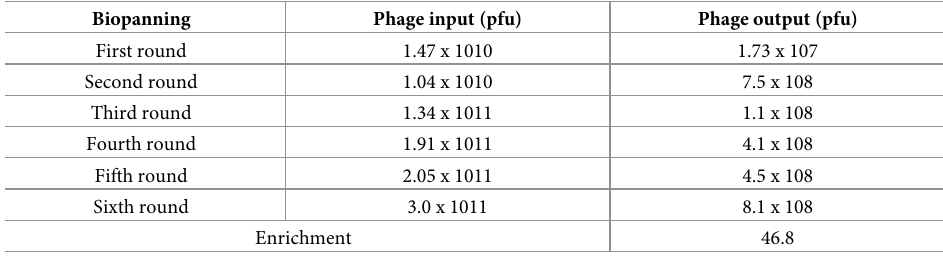
Table 1. Titer of input and output phage populations throughout six rounds of